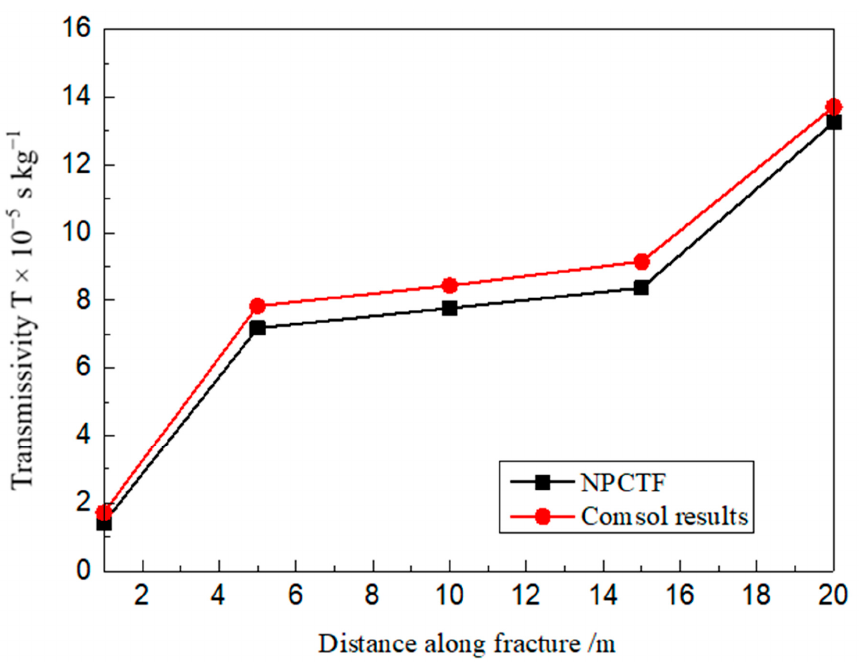
Figure 6. The transmissivity comparison calculated by the proposed NPCTF and COMSOL simula- tion in 5 fracture profiles.